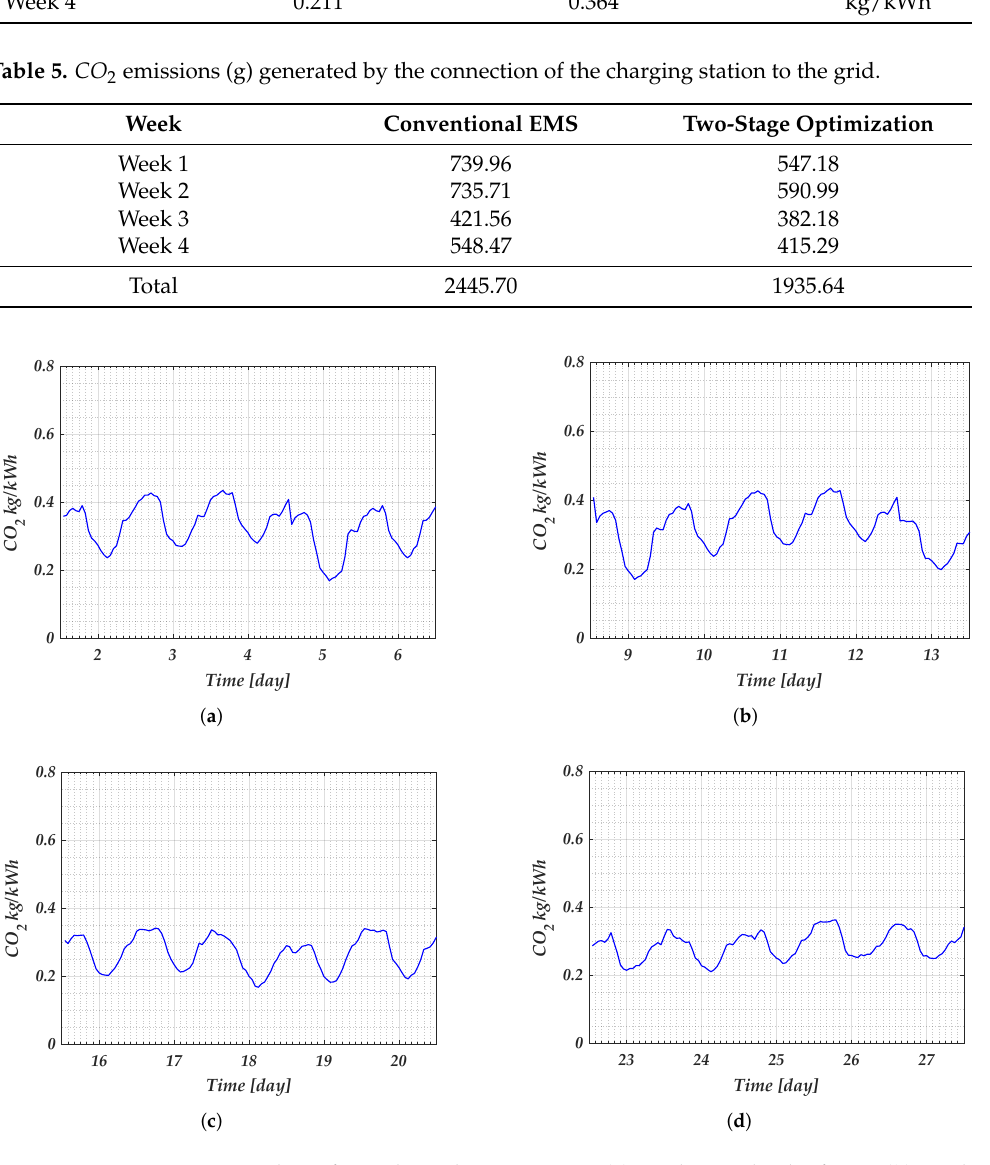
Figure 7. CO 2 variation per hour for each week in May 2022. ( a ) Week 1: 2nd–6th of May, ( b ) Week f 2: 8th–13th of May, ( c ) Week 3: 15th–20th of May, ( d ) Week 4: 22nd–27th of